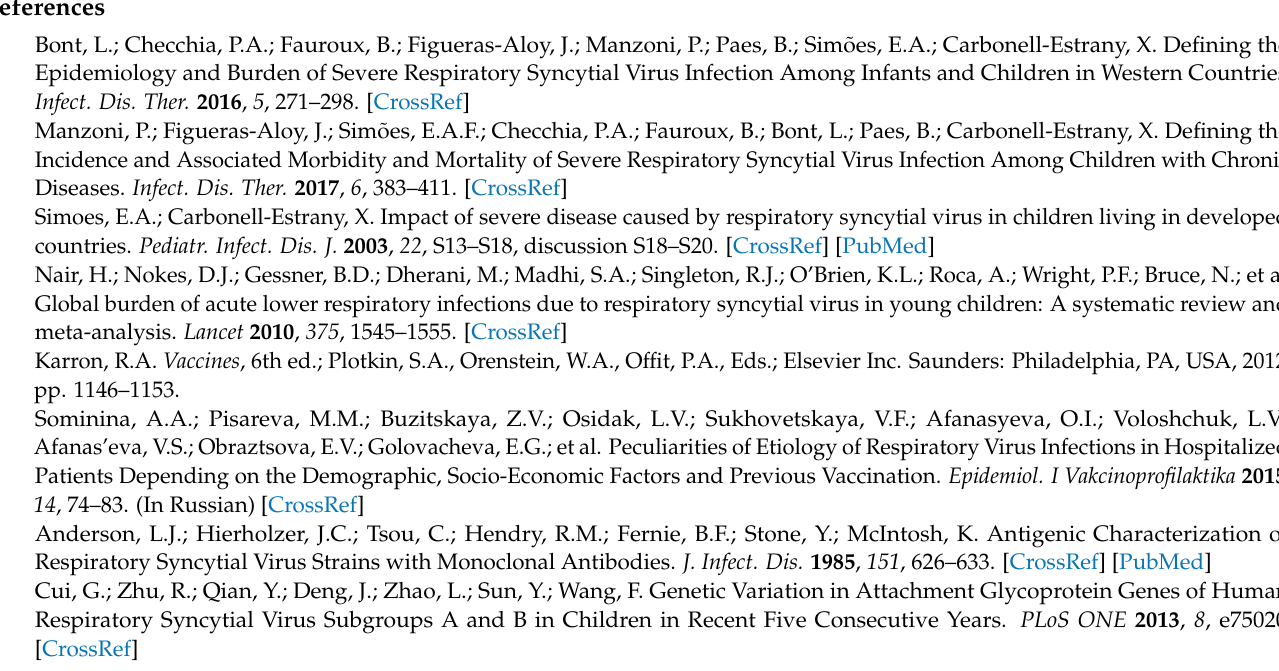
matrix containing squared root of the pairwase distances using dist.alignment function from “seqinr” package [22]. Black line in the box represents the median value, the length of the box represents the interquartile range (IQR), i.e. the difference between the lower (Q1) and the upper (Q3) quartile. Figure S2: G protein amino acid alignment of St. Petersburg RSV-A isolates, 2013–2014 epidemic season. With grey shadow for 2.1 subcluster, orange—3.1 subcluster. All substitutions discussed are filled with grey, 2.1 subcluster defining substitutions are filled with green, extra substitution defining 3.1 subcluster is filled with brown. Table S1: The occurrence of amino acid substitutions with predicted functional significance in RSV-A G protein dataset (CD—central domain, TMD— transmembrane domain, I HVR—I hypervariable region, II HVR—II hypervariable region). Unique substitutions observed in Russian sequences only are